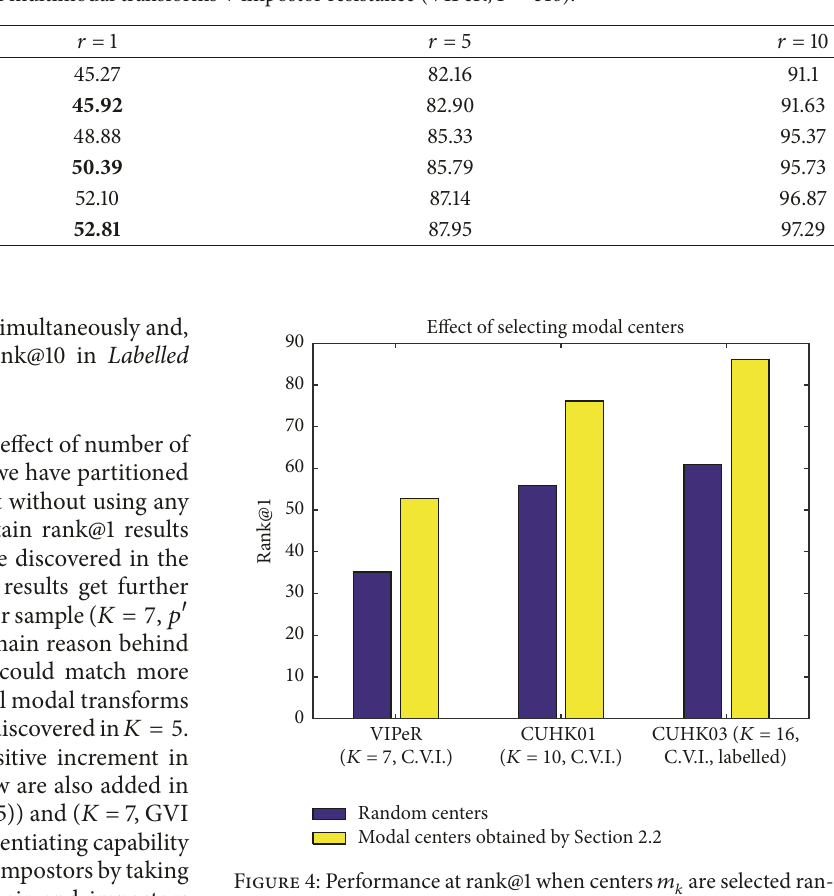
Table 4: Effect of multimodal transforms + impostor resistance (VIPeR, 𝑃 = 316).